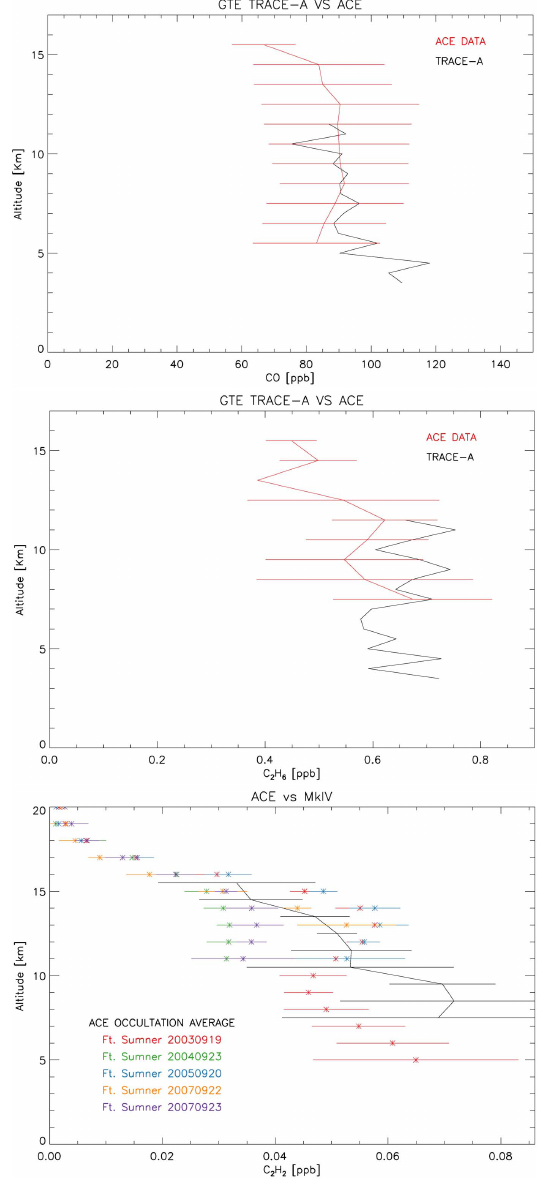
Fig. 5. Comparison of ACE-FTS average profile and MkIV-FTS profiles. Top panel CO, middle panel C 2 H 6 and lower panel C 2 H 2 .